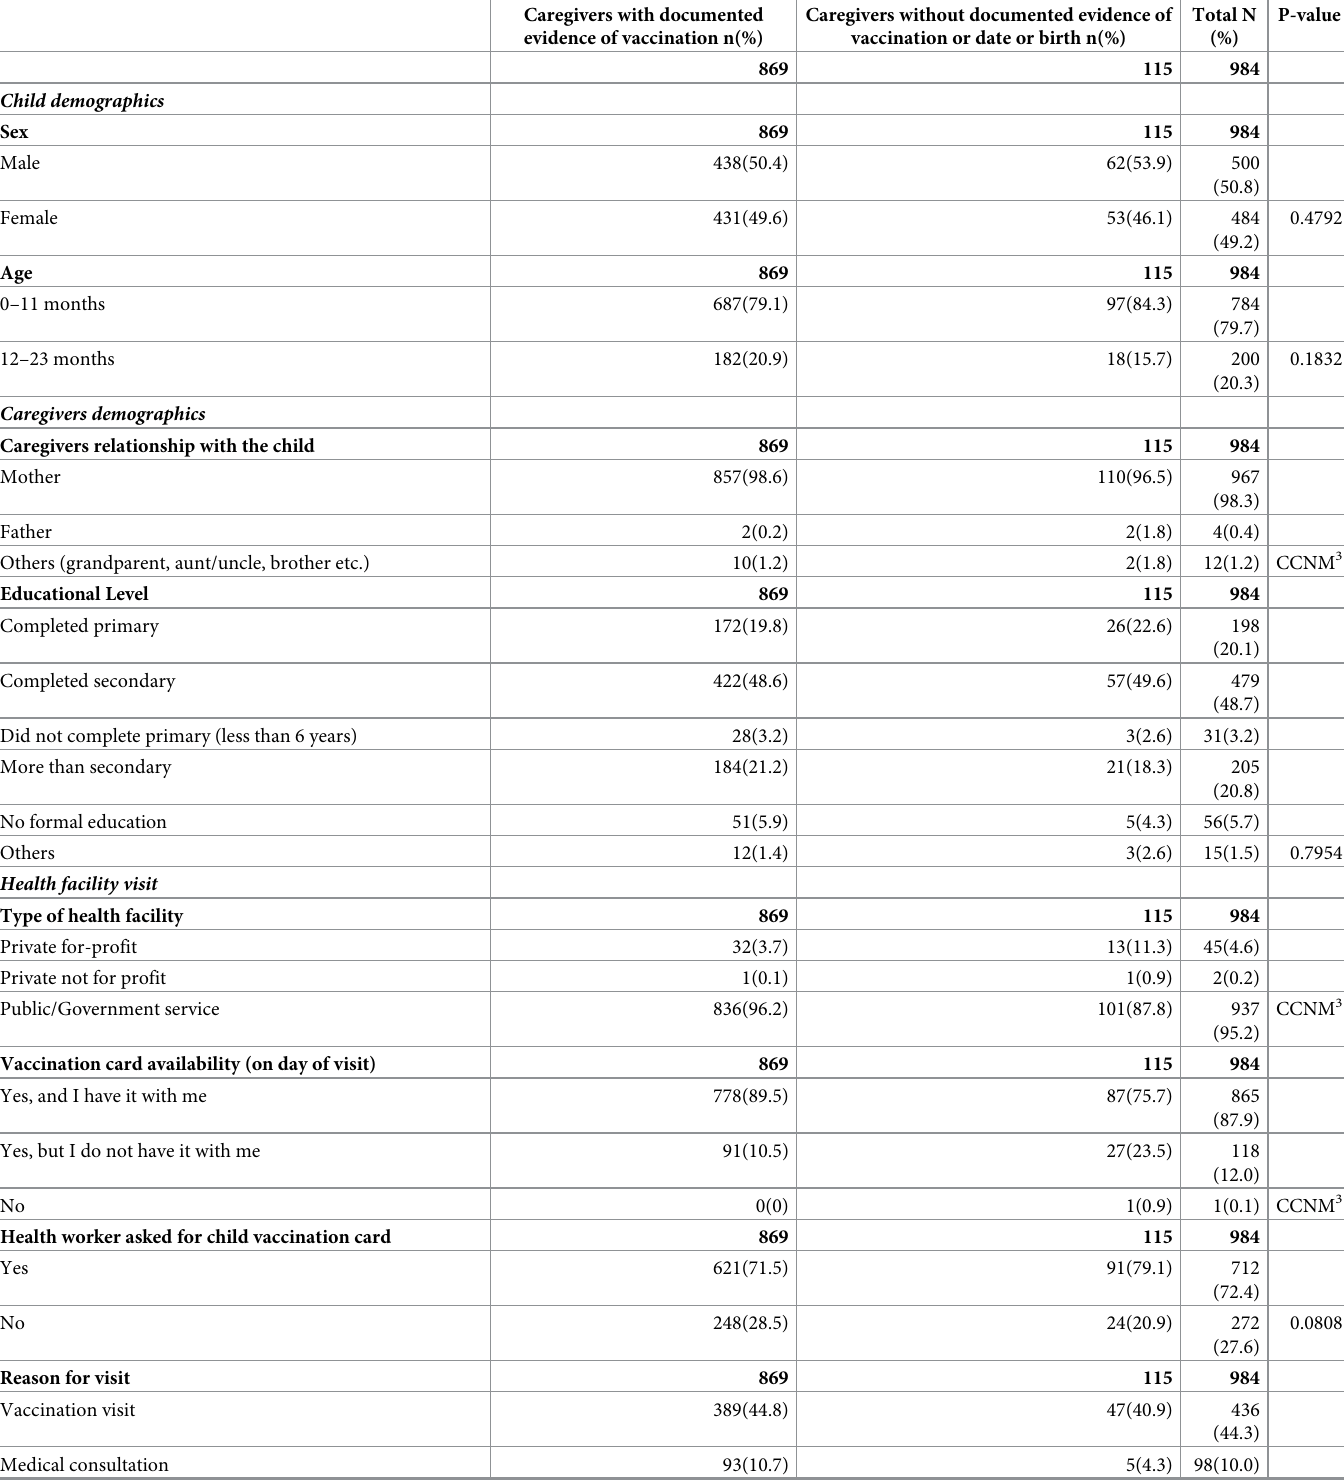
Table 3. Characteristics of caregivers of children 0–23 months surveyed during a Missed Opportunities for Vaccination (MOV) assessment with valid documented dates of birth and vaccination (n = 869), and those without (n = 115), Ondo State, Nigeria,